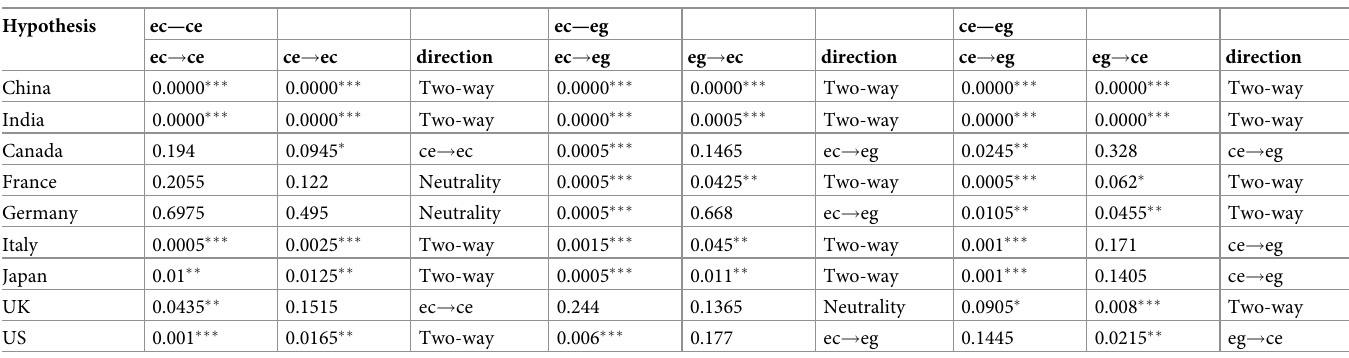
Table 4. Multispatial CCM test for per capita